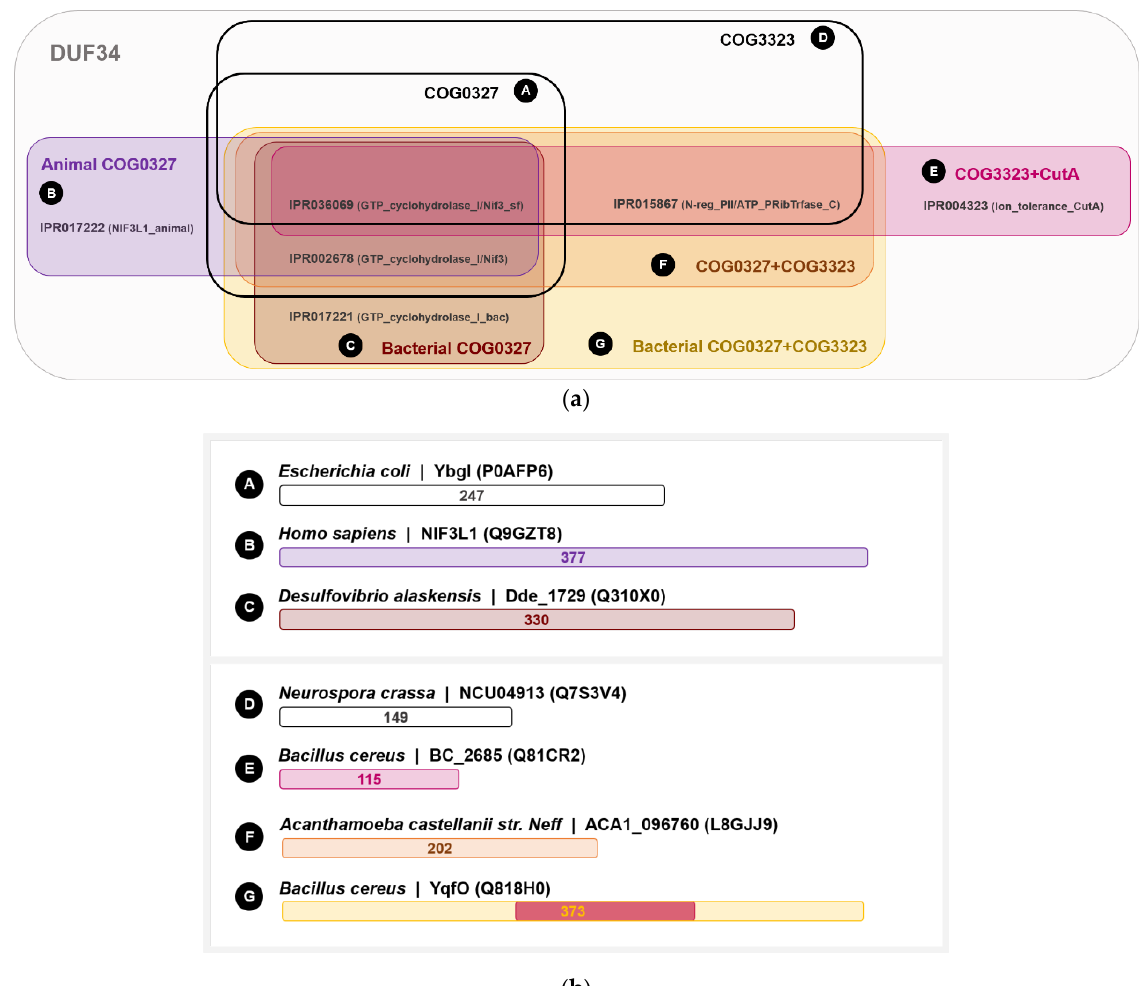
Figure 4. COG-InterPro HMM signature profile relationships and defined subgroups across DUF34 family members. The sequences of organisms across the DUF34 protein family, including all fusions and paralogs, were analyzed for co-occurrence relationships of COGs and HMM-determined InterPro family/superfamily/domain annotations. All organism homologs, paralogs & fusions were validated using eggNOG and KEGG Paralog Search. Sequences missing InterPro annotation were analyzed by NCBI CDD Search and InterProScan Search. See Data Table S5 for categories and respective COG designations/InterPro signature profiles in tabular format. The sequence source organisms considered were those also observed in Data Table S4. Groups were designated by differential keystone signatures shown in ( a ) and select representative sequences of subgroups (A–G) are shown ( b ).